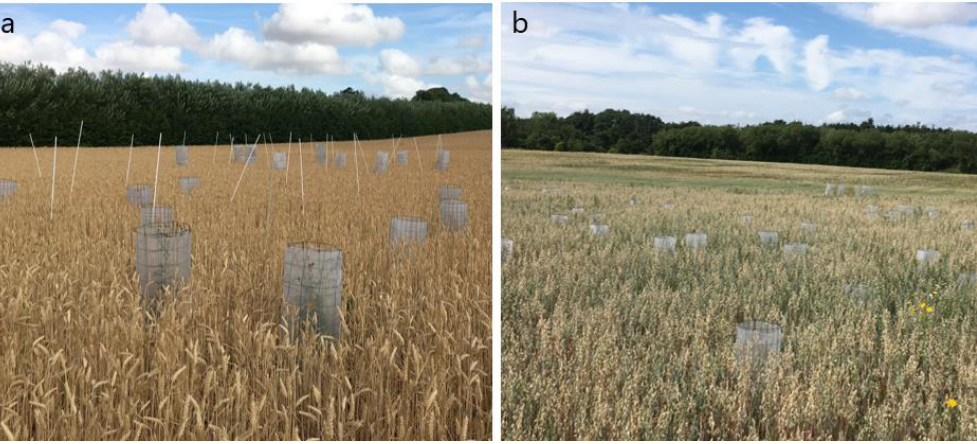
Figure 1. Seed traps placed in ( a ) wheat and ( b ) oat fields in 2018.